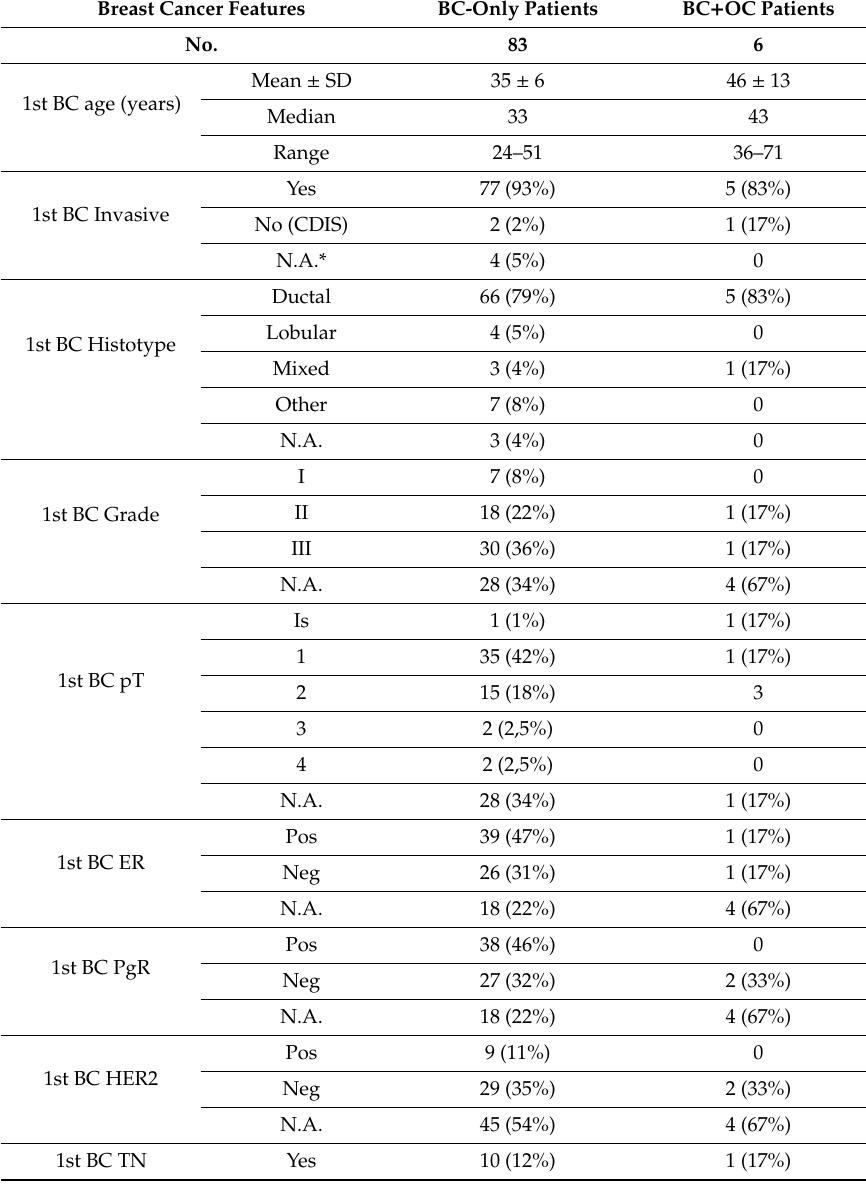
Table 2. Main features of breast cancer cases in the study cohort. BC, breast cancer; OC, ovarian cancer; TN, triple negative; ER, estrogen receptor, PgR, progesterone receptor; SD, standard deviation; N.A., data not available; * not in-situ lobular